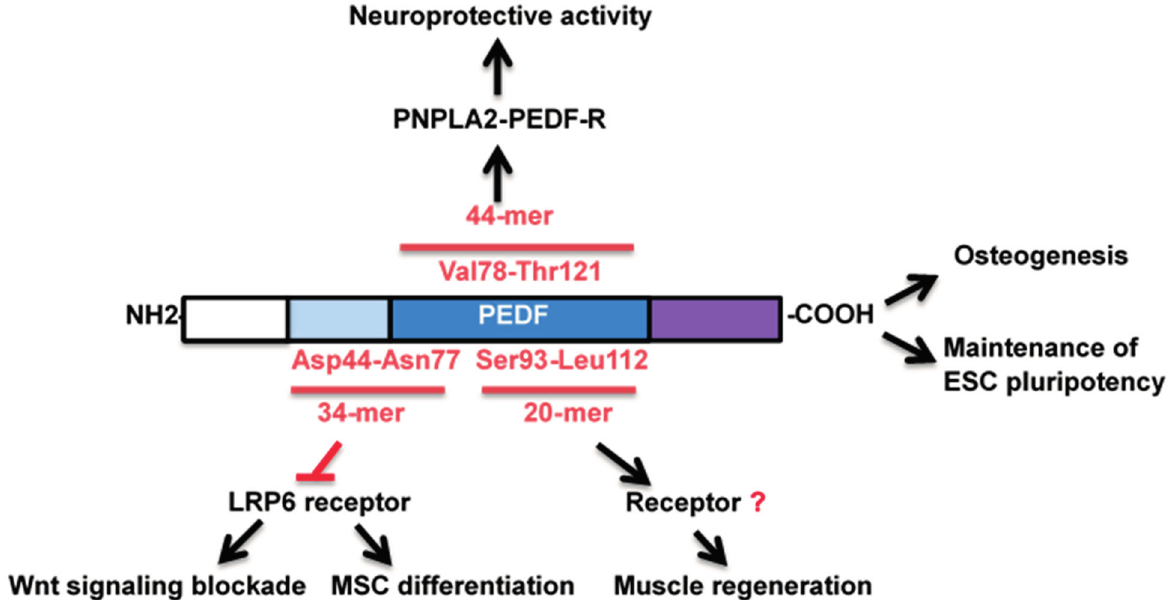
Figure 1. Schematic diagram of PEDF, its associated peptide regions, and functional effects related to stem cell biology. The N -terminus contains the well-known anti-angiogenesis effects. This region has also been implicated in inhibiting the Wnt receptor, LRP6, in differentiated cells. The 44-mer and a 20-mer within this region have been implicated in neuronal differentiation and muscle progenitor proliferation. The full-length PEDF protein has been shown to induce mesenchymal stem cells (MSC) to the osteoblast lineage and affect pluripotency of embryonic stem cells (ESC) and apoptosis of inducible pluripotent stem